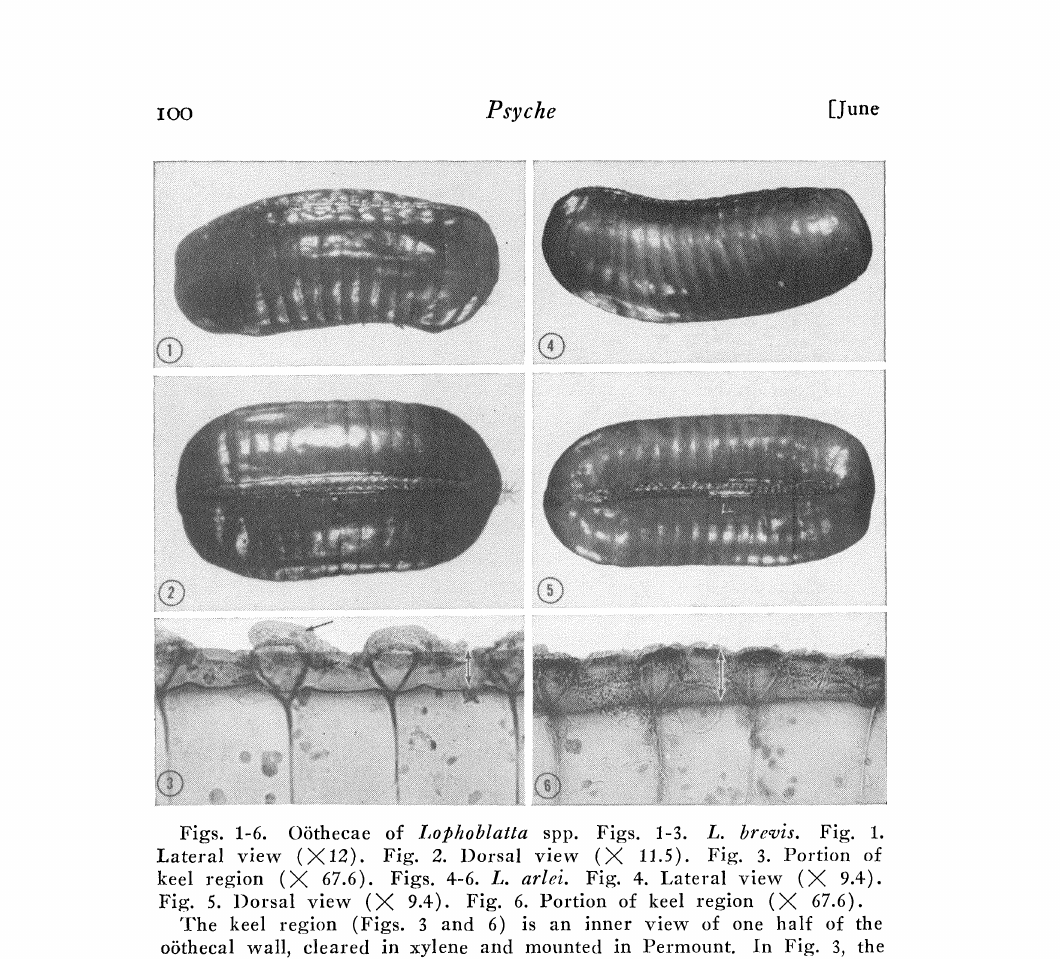
Figs. 1-6. O6thecae of .Lophoblatta spp. Figs. 1-3. L. brevis. Fig. 1. Lateral view (X12). Fig. 2. Dorsal view (( 11.5). Fig. 3. Portion of keel region (X 67.6). Figs. 4-6. L. arlei. Fig. 4. Lateral view (X 9.4). Fig. 5. Dorsal view () 9.4). Fig. 6. Portion of keel region (>(67.6). The keel region (Figs. and 6) is an inner view of one half of the o6thecal wall, cleared in xylene and mounted in Permount. In Fig. 3, the protruberances (arrow) are spongy-like bodies, normally found above each egg; in Fig. 6, these bodies were removed to show the actual margin of the keel. q’he main part of. the keel (double-headed arrows) lies flat against the eggs and only the small reduced serrations protrude